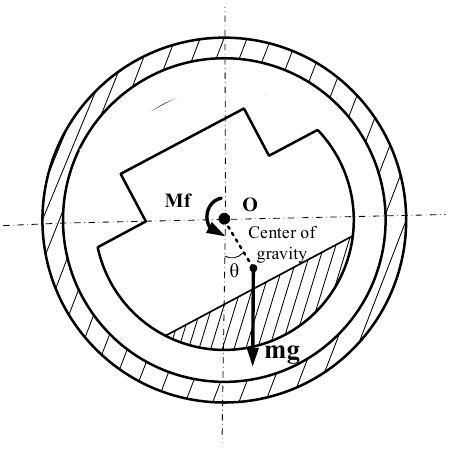
Figure 2. Mechanical model of the semi ‐ strapdown isolation rolling platform.